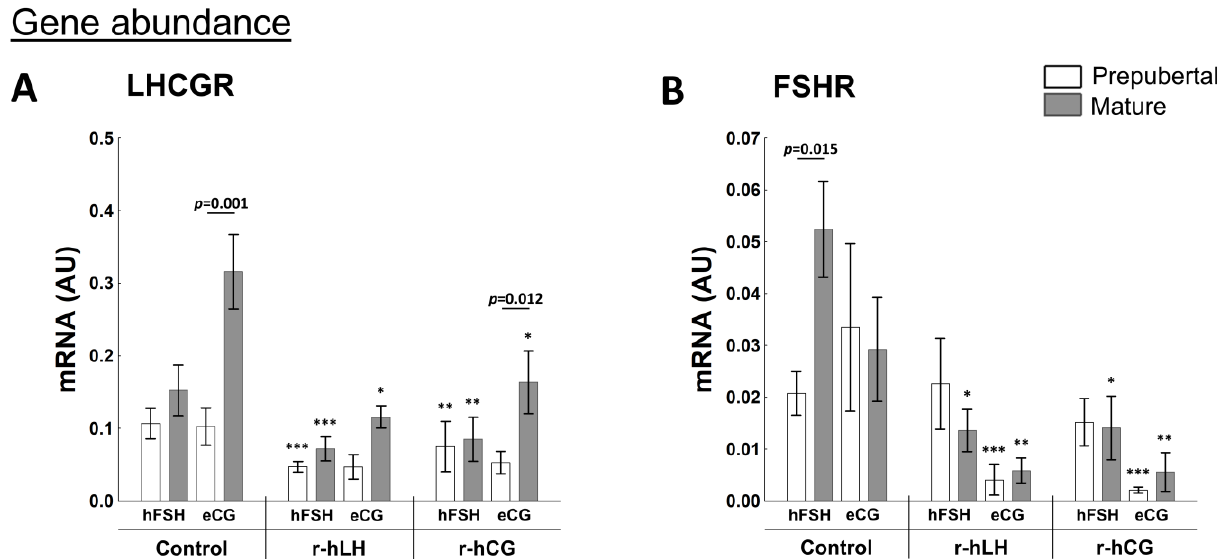
Figure 6. r-hLH and r-hCG in vitro treatments affect abundance of receptors related to progesterone and estrogen synthesis in ovarian follicles of prepubertal and mature gilts primed in vivo with hFSH or eCG. Evaluation of mRNA levels was performed for LHCGR ( A ) and FSHR mRNA ( B ) after exposition of follicular walls to r-hLH and r-hCG. Gene expression was normalized to the geometric mean of ACTB and GAPDH , identified as the best reference genes by NormFinder algorithm. Data were analyzed using one-way ANOVA with Tukey post-hoc tests and are presented as mean ± SEM (n = 6 per group); * p < 0.05; * * p < 0.001; ** * p < 0.0001 for control vs. hLH or hCG treatment. Line with a p -value denotes significant differences between prepubertal and mature gilts. AU — arbitrary units.